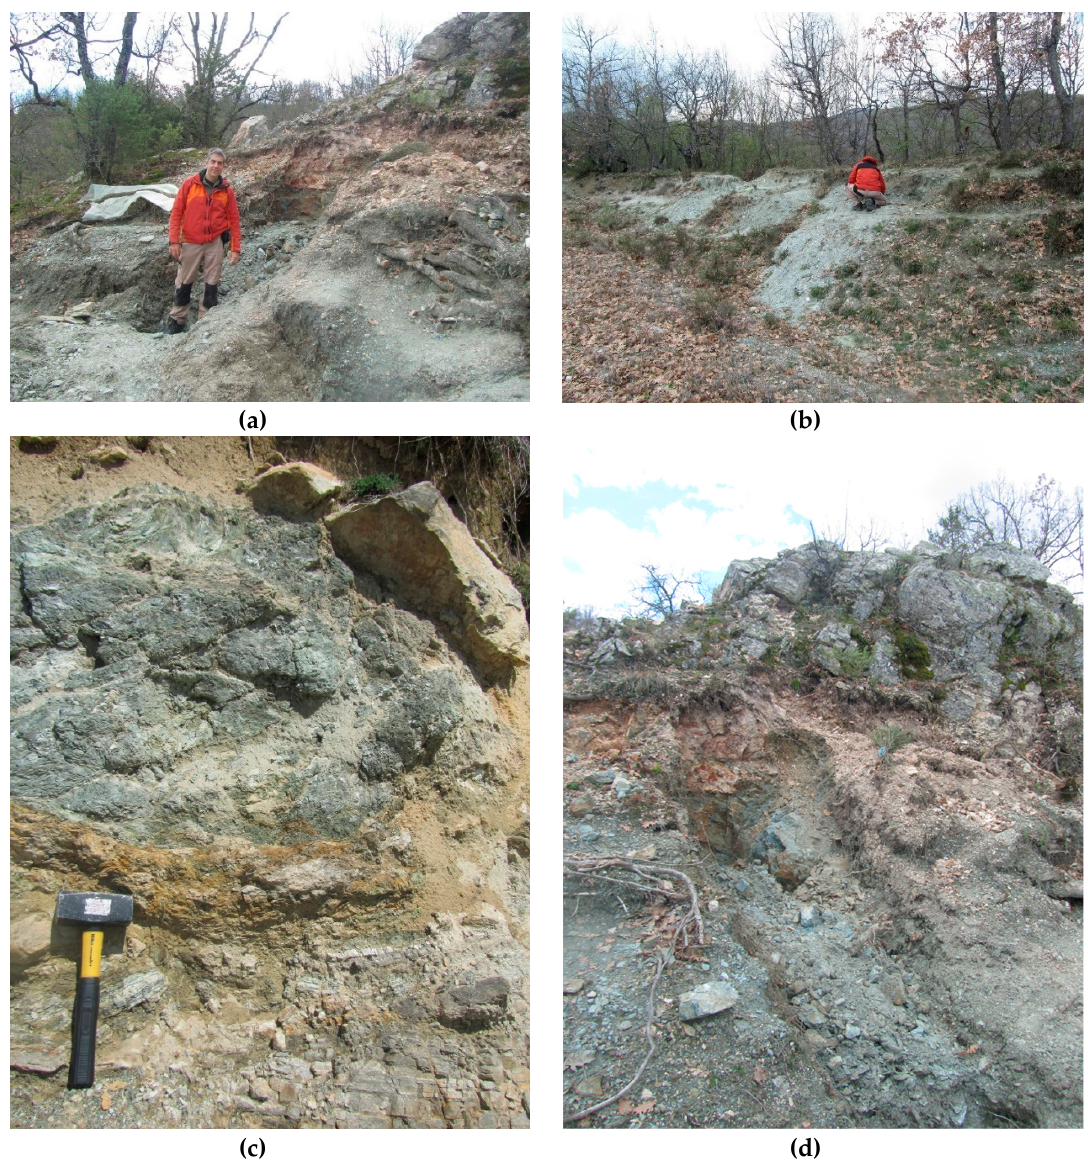
Figure 2. Locality diagram of the ruby occurrences. ( a ) PAR-1 location on top of the hill. ( b ) PAR-5 location on the roadside. ( c ) Pargasite schist boudin found approx. 500 m north of PAR-5 without any corundum. ( d ) Pegmatite on top of the ruby-bearing pargasite schist at PAR-1.